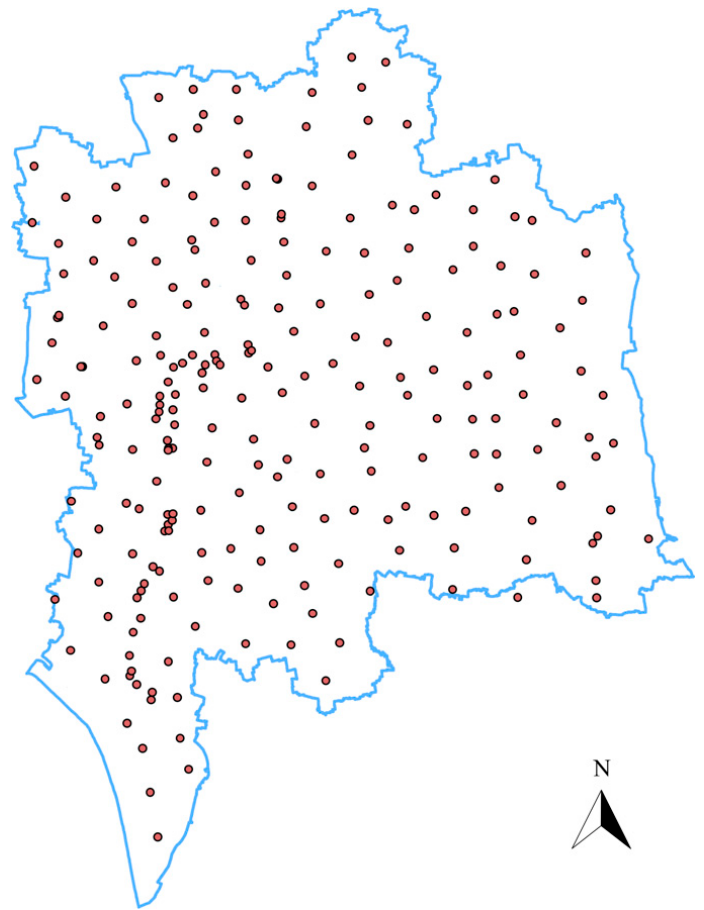
Figure 3. Overview of borehole distribution.